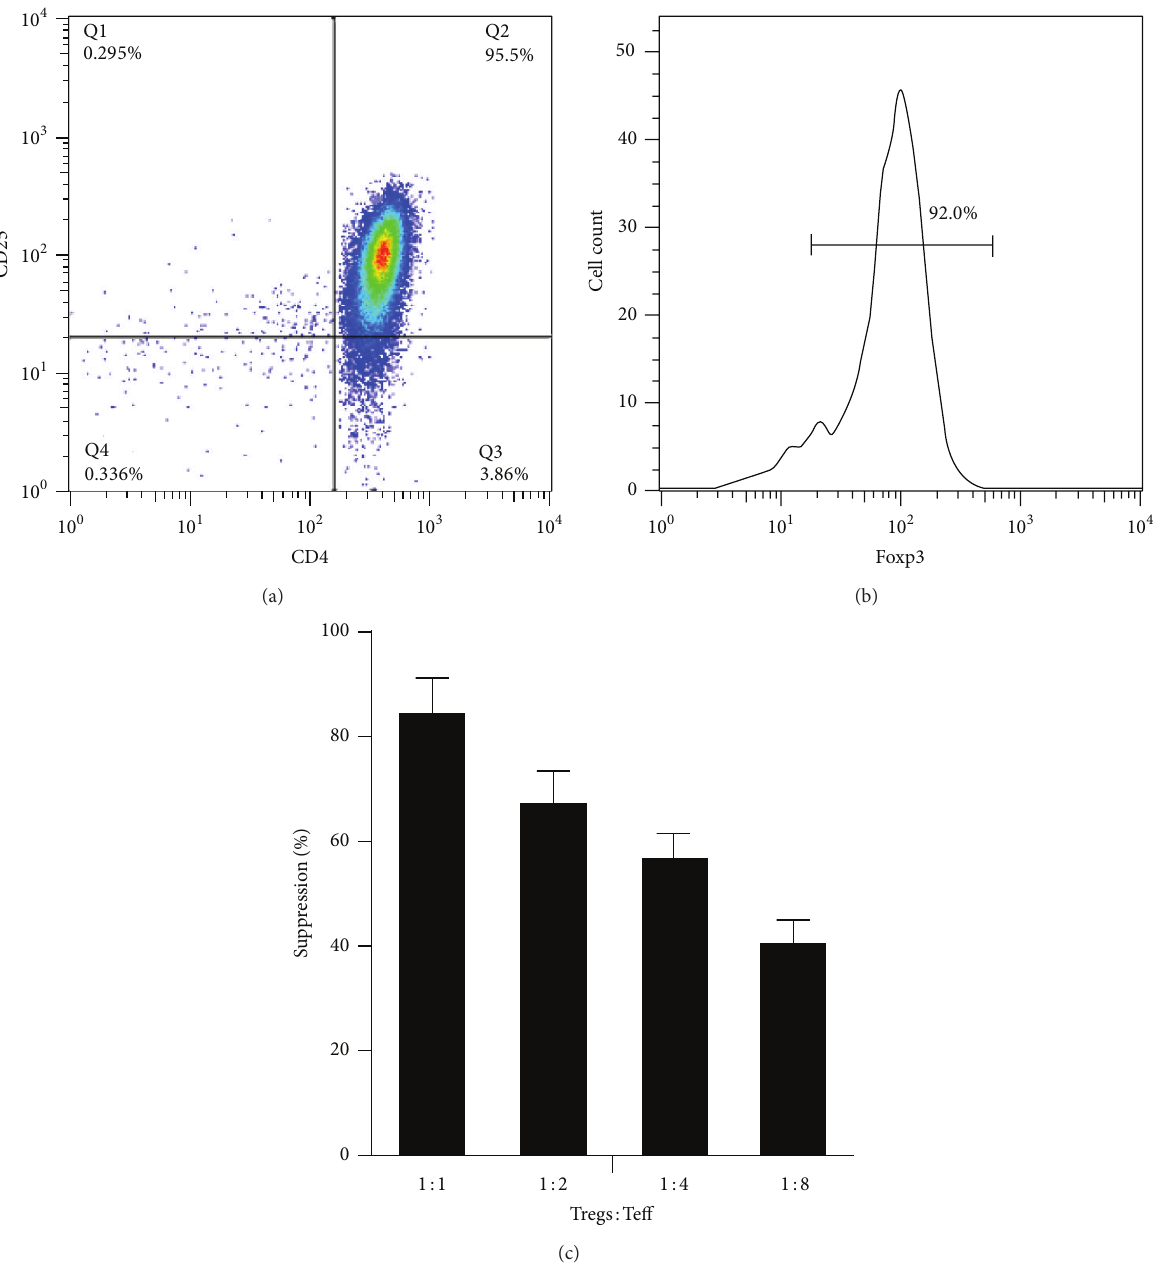
Figure 1: Isolation and identification of CD4 + CD25 + T cells. (a) The purity of CD4 + CD25 + T cells isolated from peripheral blood mononuclear cells (PBMCs) of healthy volunteers was examined by flow cytometry. (b) The percentage of the foxp3 + population among the sorted CD4 + CD25 + T cells. (c) Proliferation was evaluated by thymidine incorporation. The relative effect of CD4 + CD25 + T cells was expressed as percentage inhibition of CD4 + CD25 − T cells. Experiments were repeated 3